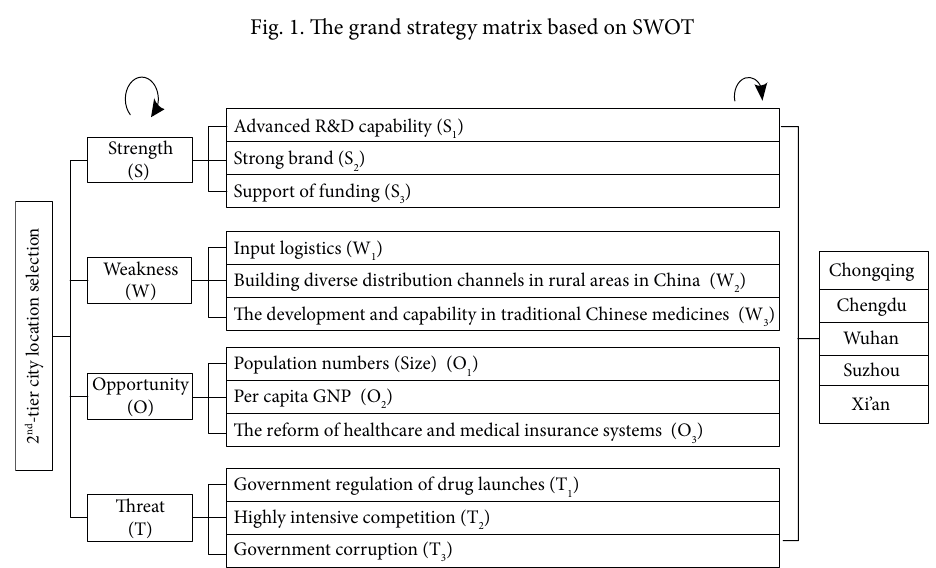
Fig. 2. A SWOT-ANP model for 2 nd -tier city location